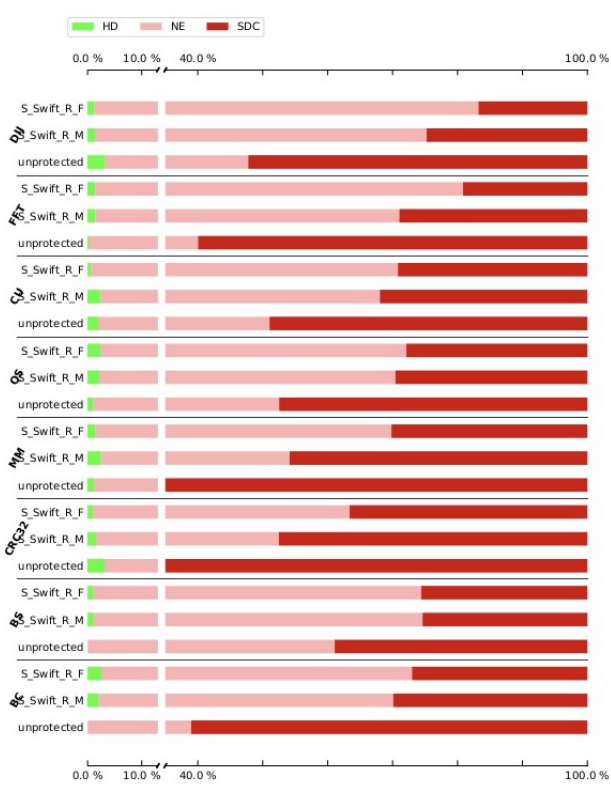
Figure A1. CFE fault injection results for 1